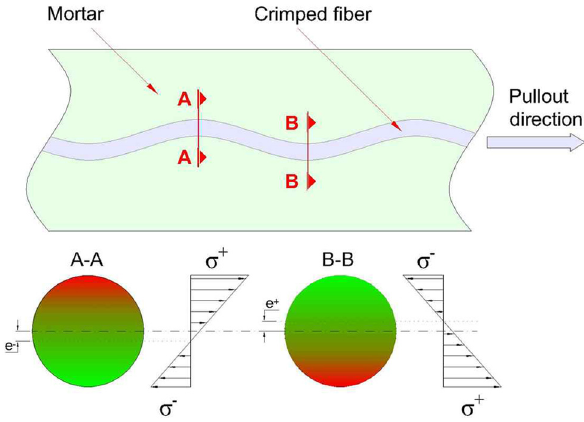
Figure 12: Stress distributions of the crimped SMA fi ber at di ff erent locations [ 27 ]